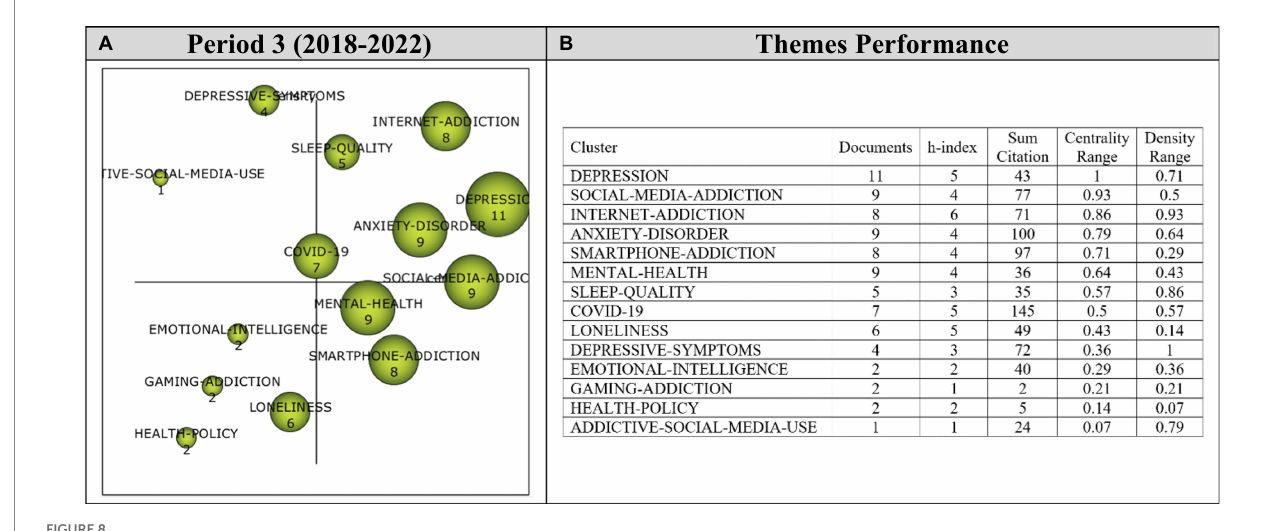
FIGURE 8 (A) Strategic diagram and (B) performance